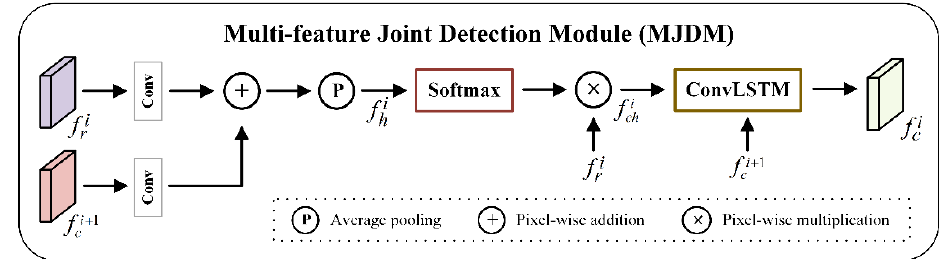
Figure 3. The architecture of MJDM.